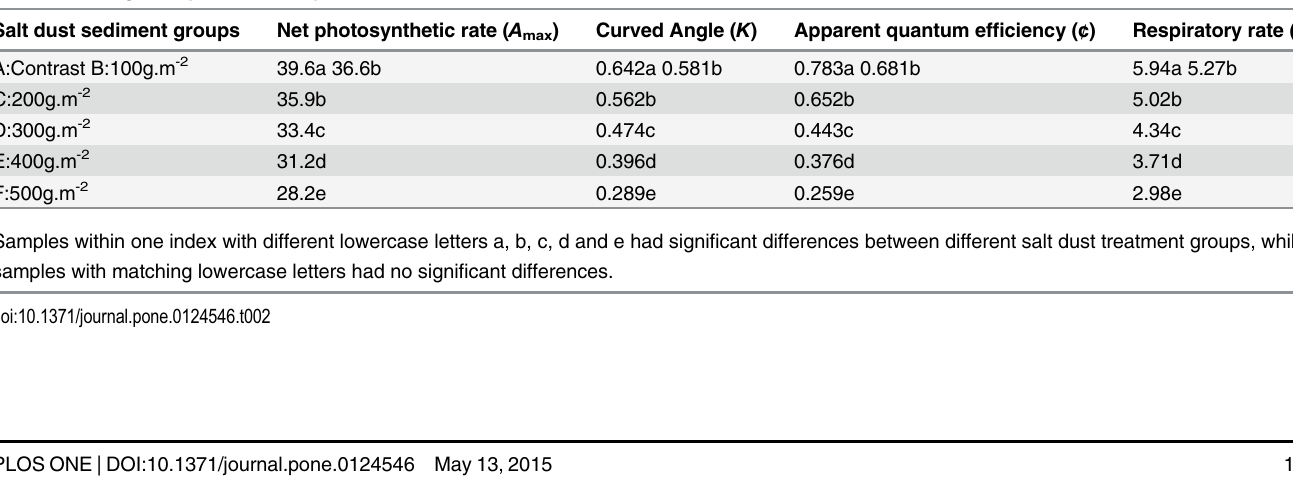
In order to determine the impact of the salt dust on the cotton canopy, we used the light re- sponse curve model [26,33]. First, we calculated the maximum net photosynthetic rate ( A and the related parameters and we generated a straight line parallel to the X-axis. Then, we cal- culated the intersection point of these two straight lines, which corresponds to the light satura- tion point. The results showed significant differences in the curved angle ( K ), apparent control and five salt dust treatment groups. The K , φ , A max and R ady all decreased in the five dust deposition had significant influence on K , φ , A max and R ady values of different groups (Table 2), the LSD test showed that among five salt dust groups and the control group, there were significant differences between A and (B, C) and D, and E and F groups ( P < 0.05), but there was little difference between B and C groups (100 g.m -2 and 200 g.m -2 ).